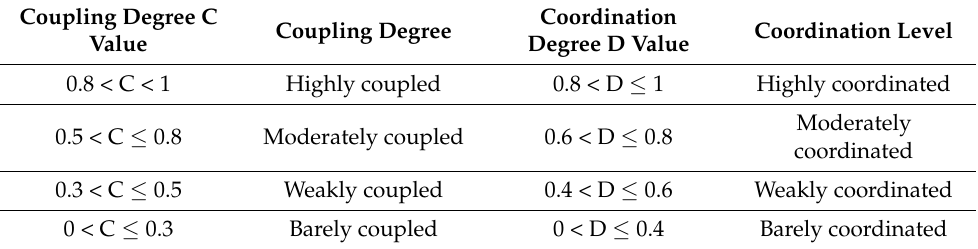
Table 4. Classification standard of coupling coordination